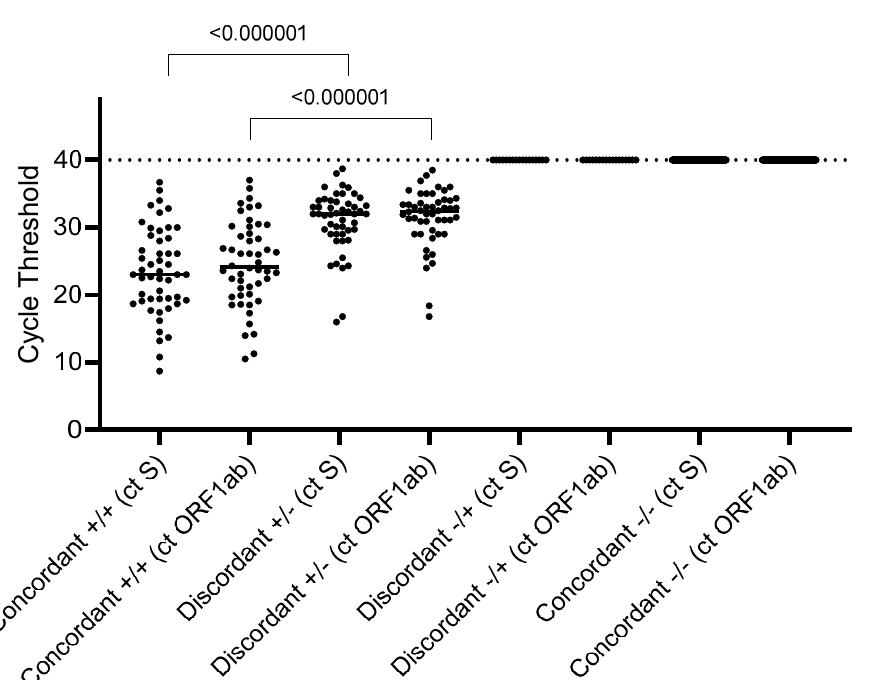
Figure 1. SARS ‐ CoV ‐ 2 RT ‐ qPCR cycle thresholds against concordance results between RT ‐ qPCR and LumiraDx SARS ‐ CoV ‐ 2 Ag test. One ‐ sided p ‐ values comparing Ct of concordant samples (+/+) and Ct of discordant samples (+/ − ) were calculated by a Mann–Whitney U test. p ‐ values < 0.05 were considered statistically significant. Ct = Cycle threshold; ORF1ab = open reading frame 1ab; S = spike.